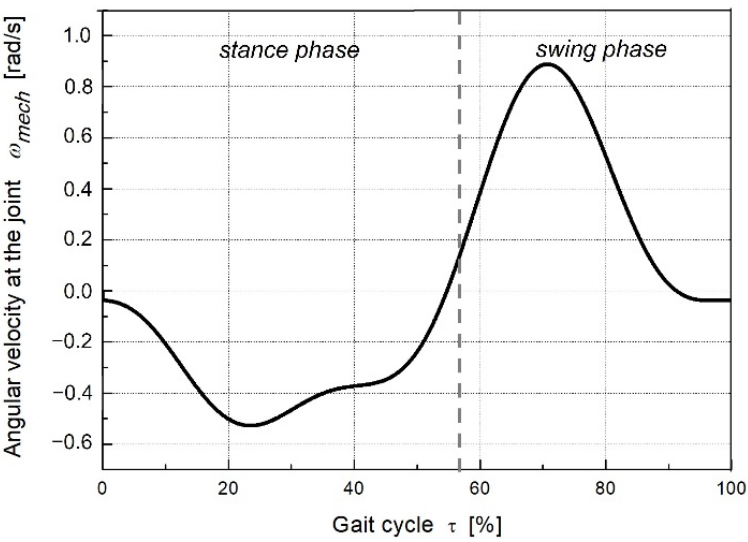
Figure 8. Graph of the angular velocity at the hip joint for the entire gait cycle.